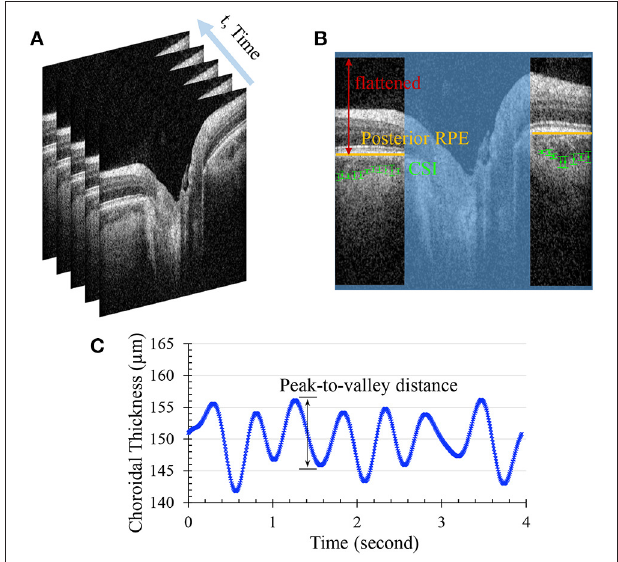
FIGURE 1 | (A) Sequential OCT B-scans of the posterior eye centered at the optic nerve head (B) Automated segmentation for the choroidal scleral interface (CSI). The optic nerve region was excluded from the region of interest, and the posterior retinal pigment epithelium (RPE) of each side of the optic nerve was flattened before the graph search for CSI nodes. (C) Filtered choroidal thickness waveform. The average peak-to-valley distance was calculated as choroidal thickness